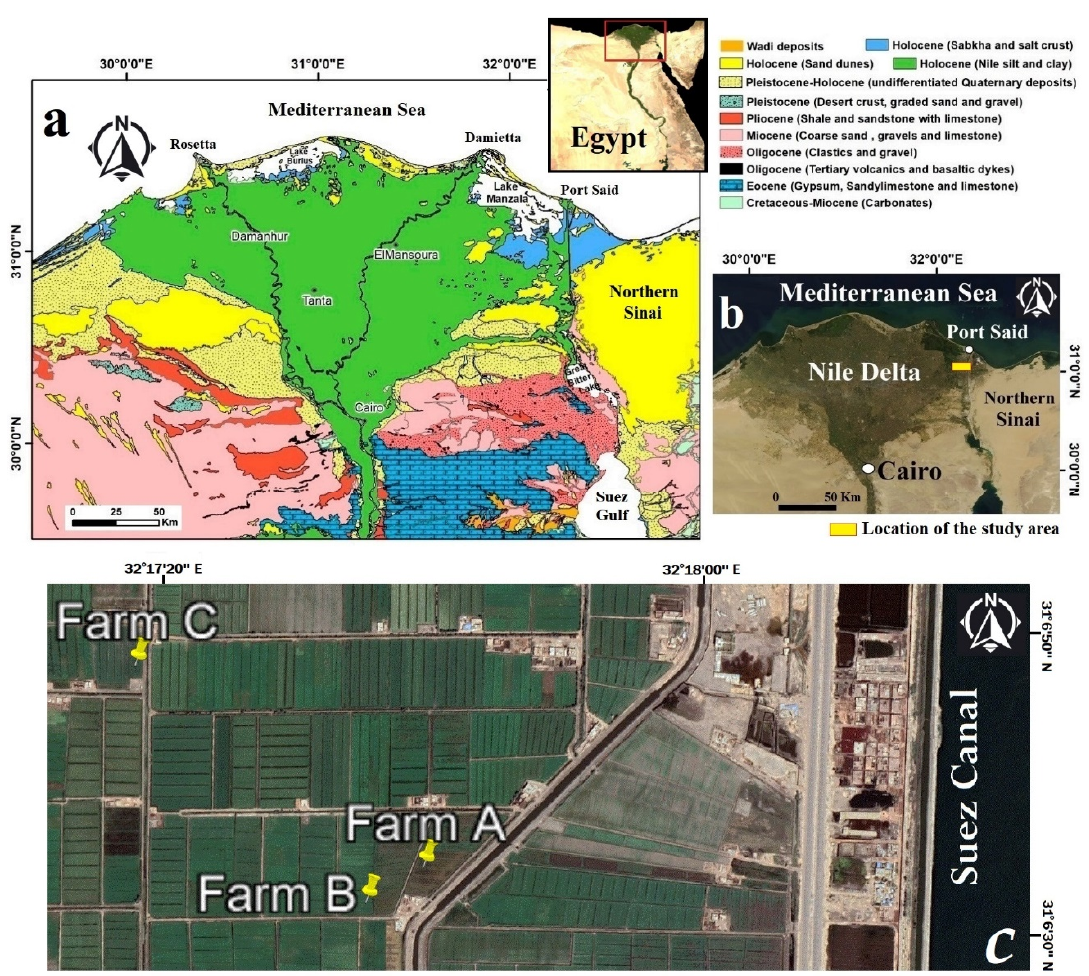
Figure 1. ( a ) Geological map of the Nile Delta (modified after Conoco [15] and Hassan et al. [16]), ( b ) location map of the recently reclaimed area denoted by the white rectangle, and ( c ) location of the three farms.